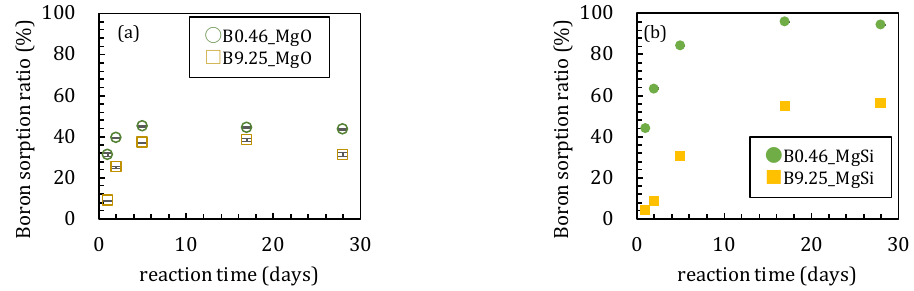
Figure 1. Changes of boron sorption ratios with time for the sorption of 0.46 and 9.25 mmol/L boron on MgO ( a ) without amorphous silica and ( b ) with amorphous silica. Data with error bars indicate the standard error of three samples.